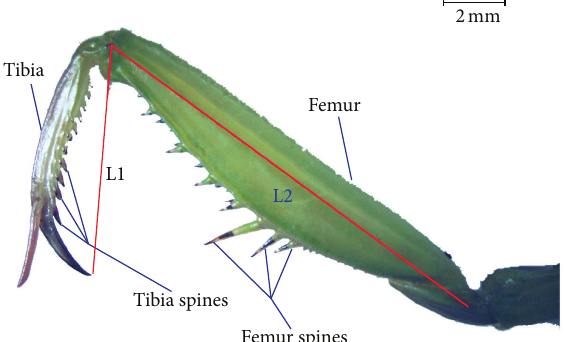
Figure 1: Praying mantis’s